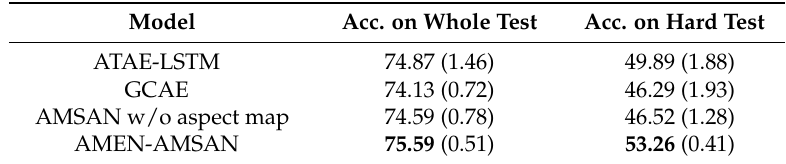
Table 4. Performance comparison of the proposed model with its baselines on the restaurant dataset of